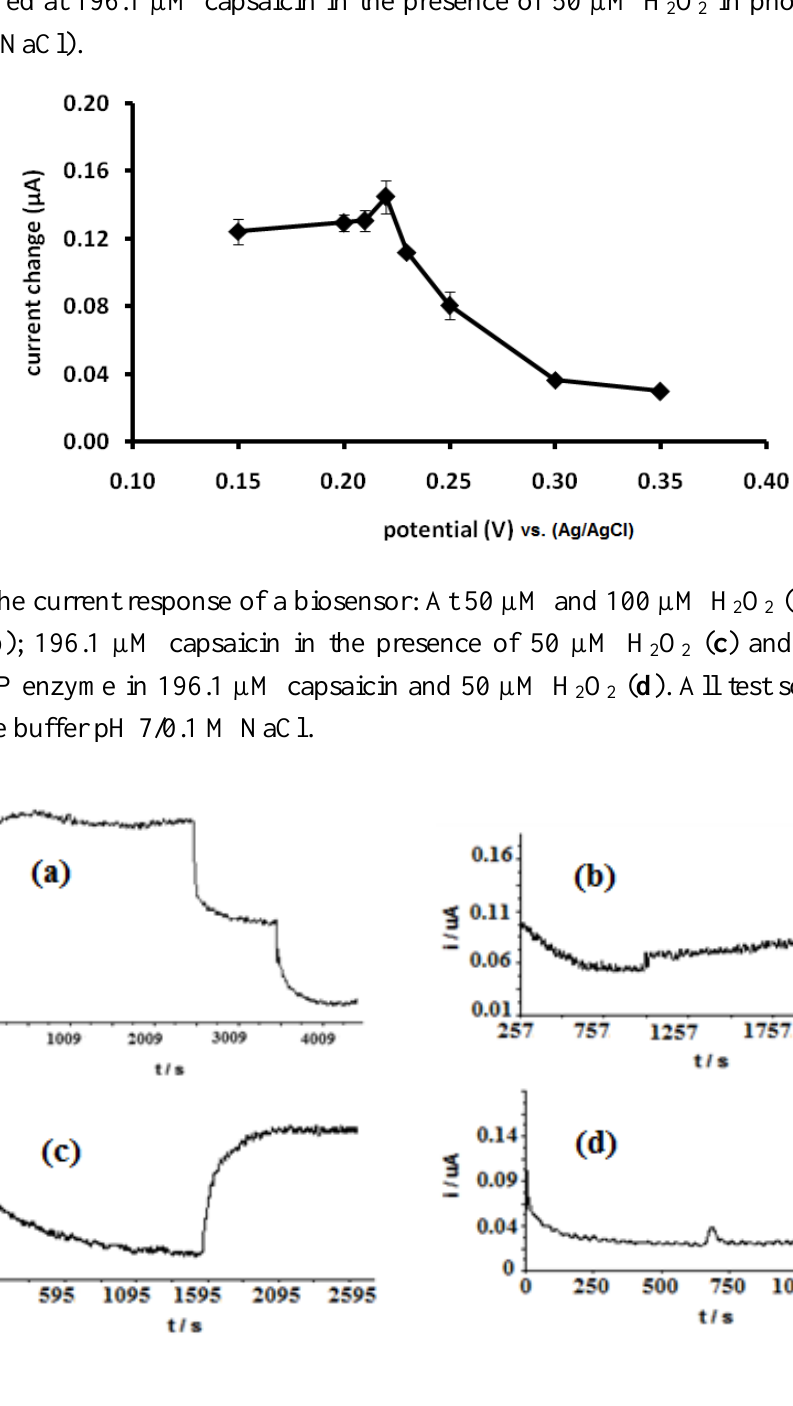
O in phosphate buffer 2 2